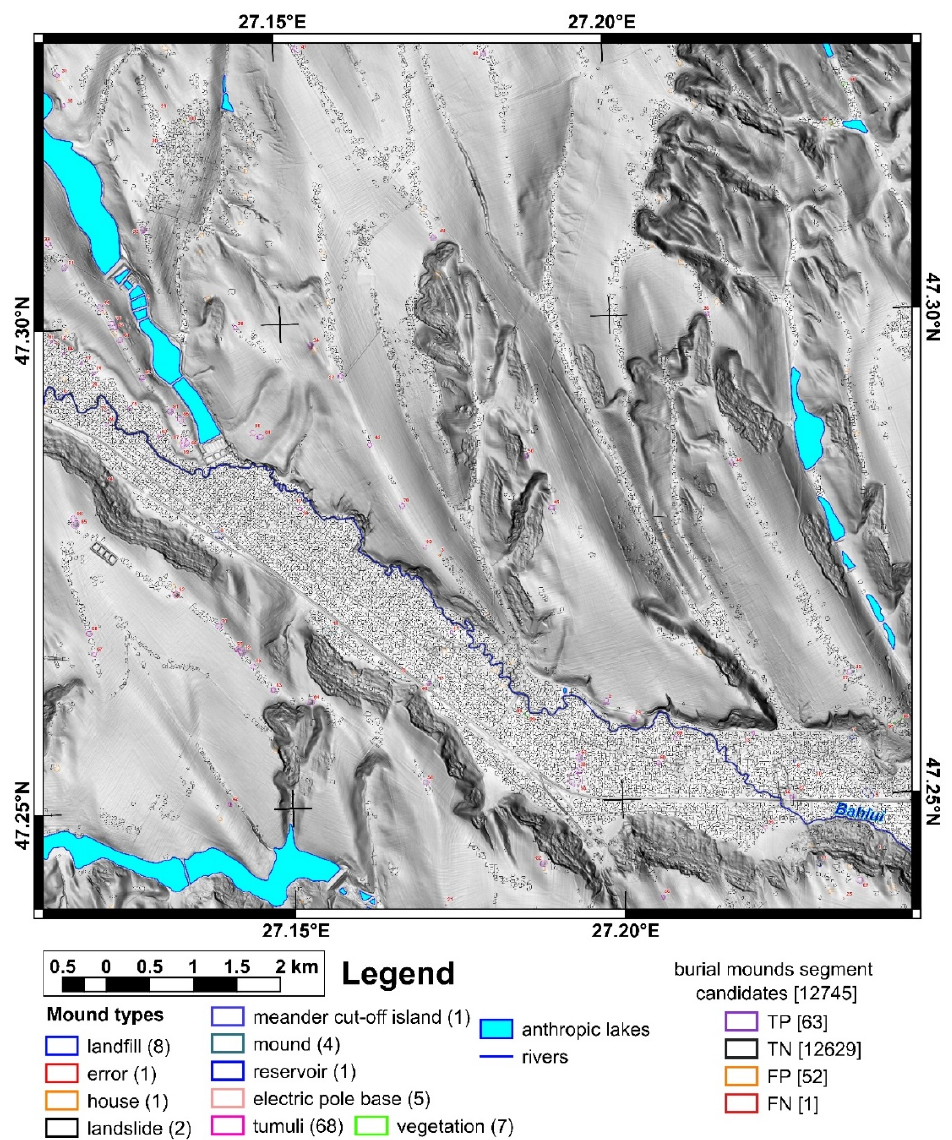
Figure 17. The burial mounds local convexity watershed segments candidates for the northern study area. (a high-resolution version can be found at https://doi.org/10.6084/m9.figshare.11798694.v2)